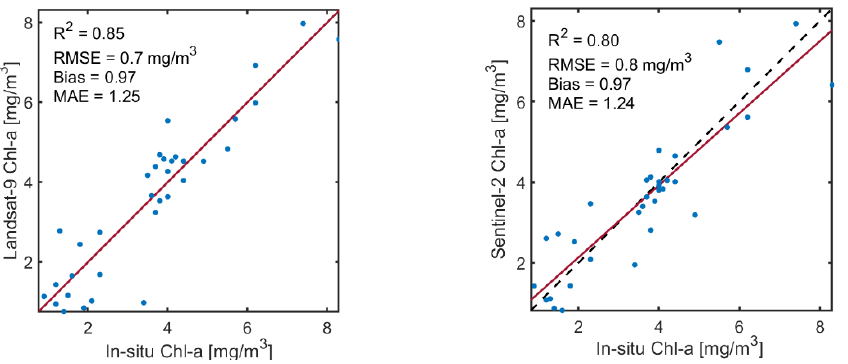
Figure 15. In situ matchup validation of Chl-a retrieval from Landsat-9 and Sentinel-2 imagery in San Francisco Bay.